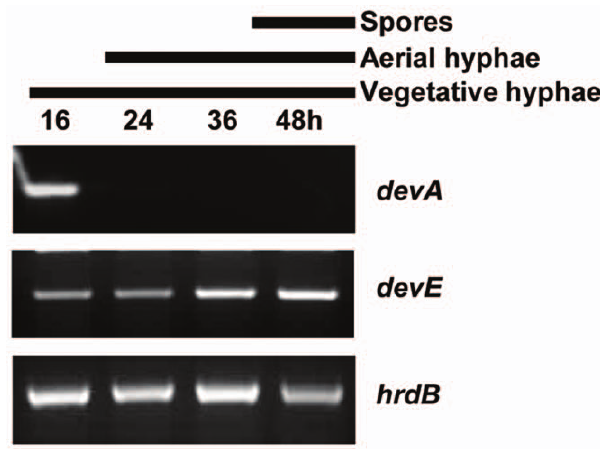
Figure 2. Transcriptional analysis of devA & devE . RT-PCR of devA and devE during development of S.coelicolor M600 on MS medium. The time points at which mycelium were harvested for RNA and the developmental stage of the culture, as judged by microscopic examination, are shown above. doi:10.1371/journal.pone.0025049.g002 PLoS ONE |